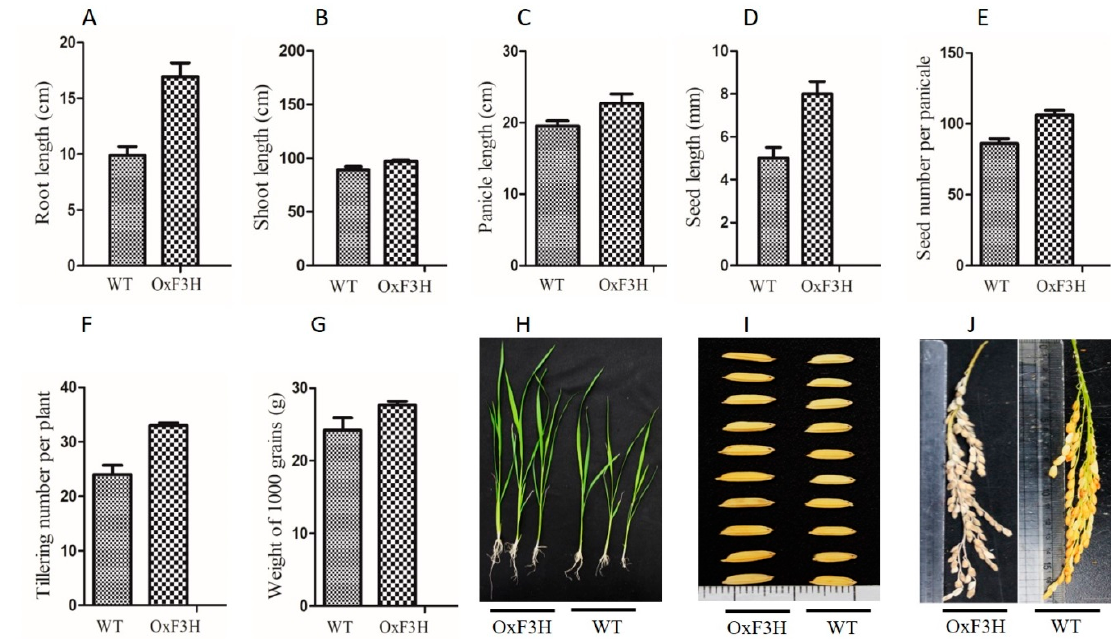
Figure 1. Evaluation of growth parameters of OxF3H and WT plants. ( A ) Root length, ( B ) shoot length, ( C ) panicle length, ( D ) seed length, ( E ) seed number per panicle, ( F ) tillering number per plant, ( G ) weight of 1000 grains, ( H ) pictorial representation of OxH3F and WT root/shoot length, and ( I , J ) pictorial representation of OxF3H and WT seed length and panicle length, respectively.